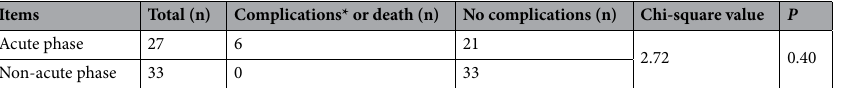
Table 8. Comparison of the efficacy of acute and non-acute endovascular treatment in patients with Stanford type B IMH. *Progression of aortic dissection, pseudoaneurysm, rupture, visceral arterial perfusion, lower limb